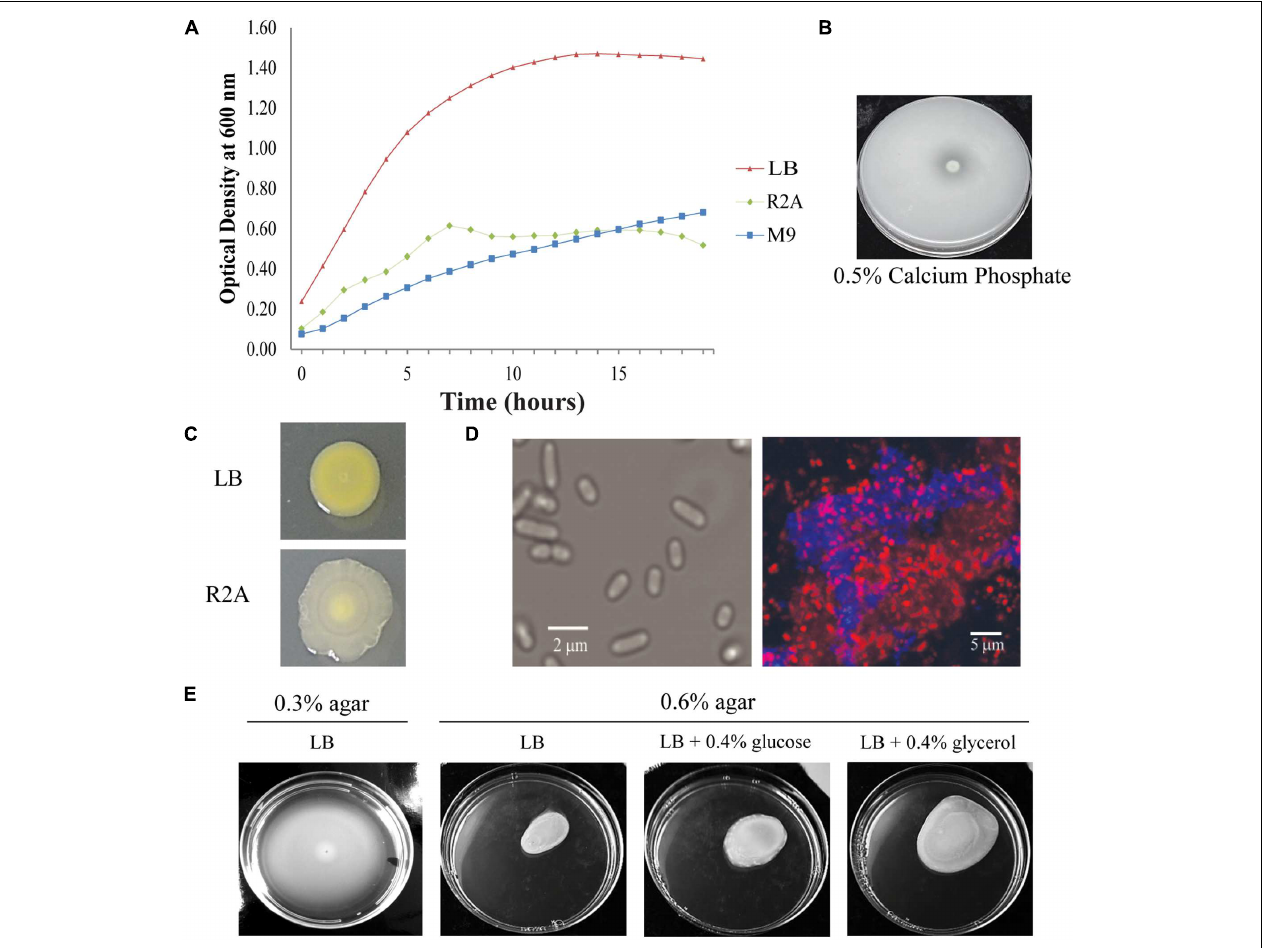
FIGURE 2 | Phenotypic characteristics of Pantoea sp. YR343. (A) Growth of wild type Pantoea sp. YR343 grown in liquid LB, R2A, and M9 media. (B) Phosphate solubilization by Pantoea sp. YR343 is shown by a zone of clearing surrounding the colony. (C) Colony morphology of Pantoea sp. YR343 on LB (top) versus R2A (bottom) agar plates. (D) Bright field image of Pantoea sp. YR343 grown in R2A medium (left). (Right) Cellulose production in Pantoea sp. YR343 biofilm as detected by Calcofluor White staining (blue). The distribution of cells is indicated by staining with Syto61 (red). (E) Swimming and swarming motility of Pantoea sp. YR343. Swimming motility was characterized using LB medium with 0.3% agar (left) and swarming motility was characterized on LB medium with 0.6% agar, or on LB medium with 0.6% agar supplemented with 0.4% glucose or glycerol